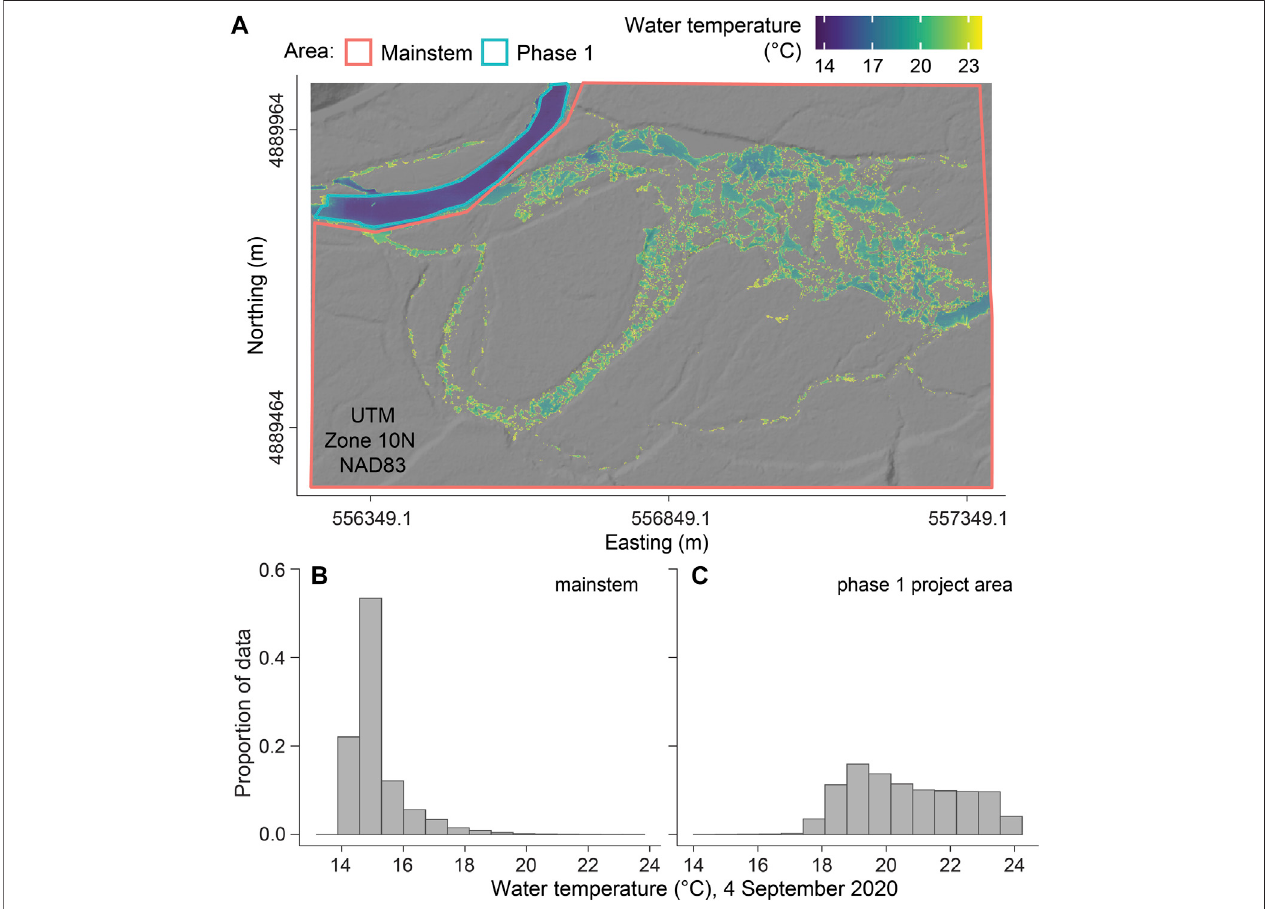
FIGURE 7 | Water temperature derived from UAS imagery of: (A) the mainstem McKenzie River, and in the phase 1 restoration reach of the South Fork McKenzie River; (B) temperature distribution of mainstem on 4 September 2020; and (C) temperature distribution of Phase 1 of Stage 0 restoration reach on 4 September 2020.